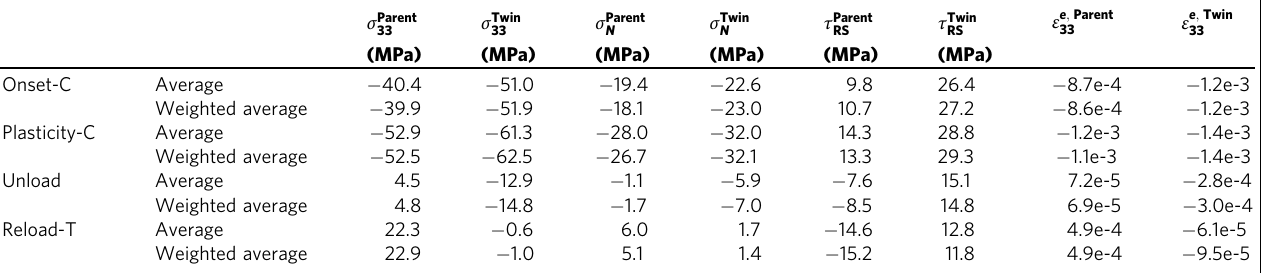
Table 2 Average and weighted average of measured quantities for twins and parents of